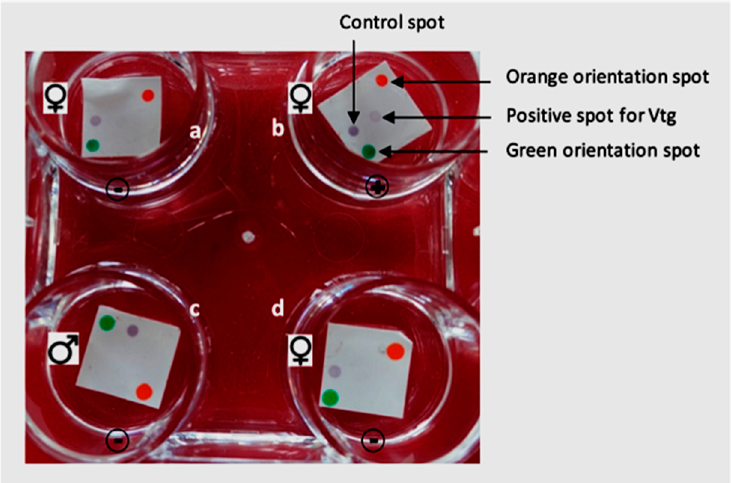
Figure 2. Test of the Pirarucu, Arapaima gigas, sexing kit on four African bonytongues, Heterotis niloticus , individuals—three females undergoing vitellogenesis and one control male. The positive Vtg detection spot was observed for two females ( a , b ) with low intensity for female ( a ), but the other female ( d ) was negative. The control male was negative as expected ( c ).